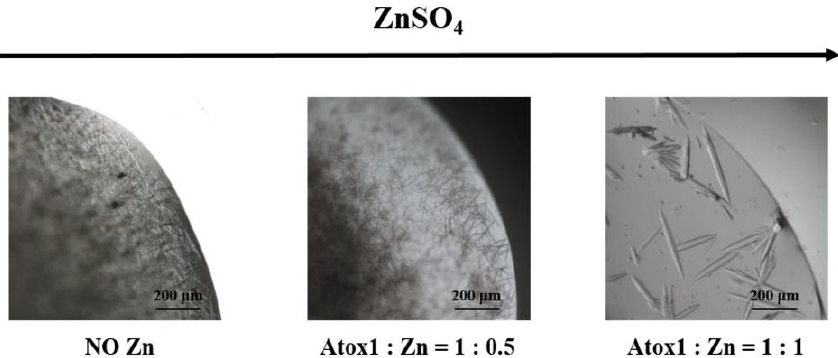
Figure 1. Microscopic images of the crystallization outcomes of Atox1 co-crystallized with increas- ing amounts of ZnSO 4 .